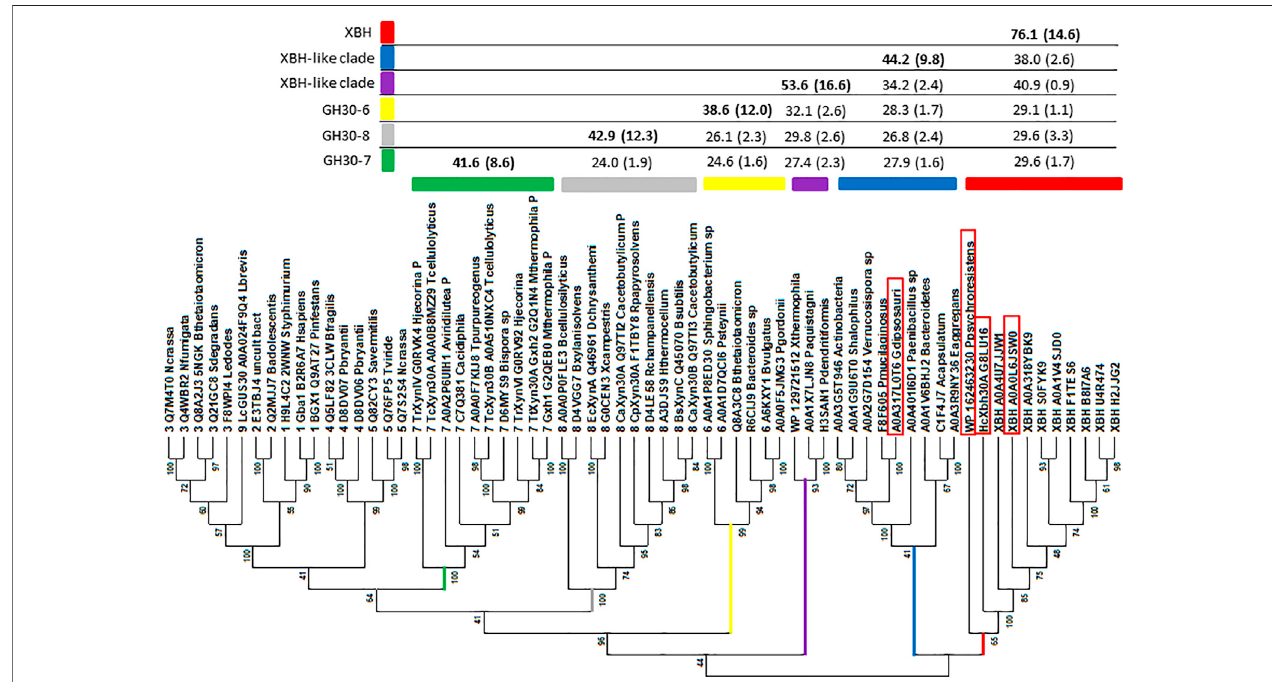
FIGURE5| PhylogeneticsanalysisdistinguishingtheGH30subfamilybranchesandhighlightingthenewXBHsubfamily(redbranch).Thesequencesetincludesall subfamily member sequences determined through published reports or protein structure database deposits collected from CAZy as well as a group homologous to Ac Xbh30A. Sequences were trimmed to consist of only the ( β / α ) 8 + β complete GH30 domain (St John et al., 2010). Sequences were aligned using MAFFT (Katoh and Toh, 2008) with the G-INS-1 strategy and imported into MEGA X (Kumar et al., 2018) where evolutionary history was inferred by using the maximum likelihood method and the LG substitution model (Le and Gascuel, 2008). The bootstrap consensus tree inferred from 100 replicates (Felsenstein, 1985) is taken to represent the evolutionary history of the taxa analyzed (Felsenstein, 1985). The percentage of replicate trees in which the associated taxa clustered together in the bootstrap test (100 replicates) is shown next to the branches (Felsenstein, 1985). Initial trees for the heuristic search were obtained automatically by applying neighbor-join and BioNJ algorithms to a matrix of pairwise distances estimated using a JTT model and then selecting the topology with a superior log likelihood value. A discrete gamma distribution was used to model evolutionary rate differences among sites [three categories (+G, parameter (cid:1) 2.5225)]. The rate variation model allowed some sites to be evolutionarilyinvariable([+I], 0.28%sites).Thisanalysisinvolved66aminoacidsequences. Therewereatotalof878positionsinthe fi naldataset.Thesesequencesalso includedGH30-7(greenbranch),GH30-8(graybranch),andGH30-6(yellowbranch),andtwoXBH-likebranches(purpleandblue)wereanalyzedusingPRSS(Pearson, 1998).Theresultsofpercentidentityaretabulatedtodistinguishlevelsofroughsimilaritycut-offsbetweenGH30-6,-7,and-8subfamilies,theunknownXBH-likeclades, and the new XBH subfamily (red). Enzymes boxed in red were evaluated for biochemical function following DNA cloning, protein expression, and IMAC puri fi